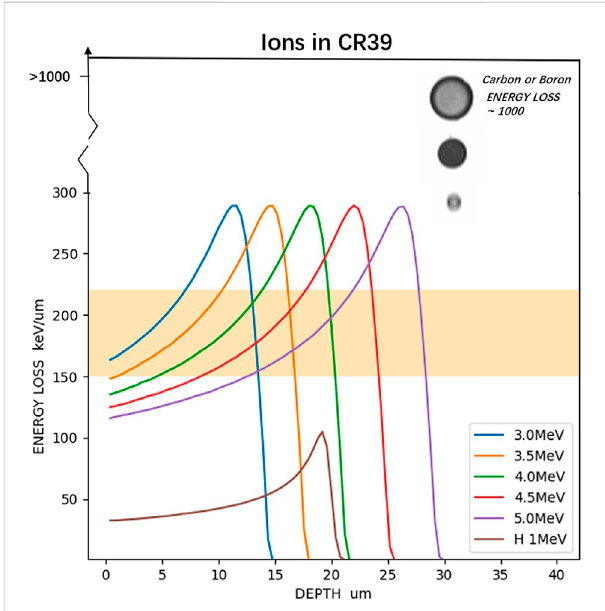
LET curves for protons and α particles in CR-39 calculated using the SRIM code [36]. The orange region indicates the estimated LET threshold of PEW-25 in CR-39 to detect the α particles [37]. Tracks of carbon/boron and α particles are shown on the top right. Tracks of carbon/boron have three times larger diameters compared to α generally, and LET of carbon is three times that of α